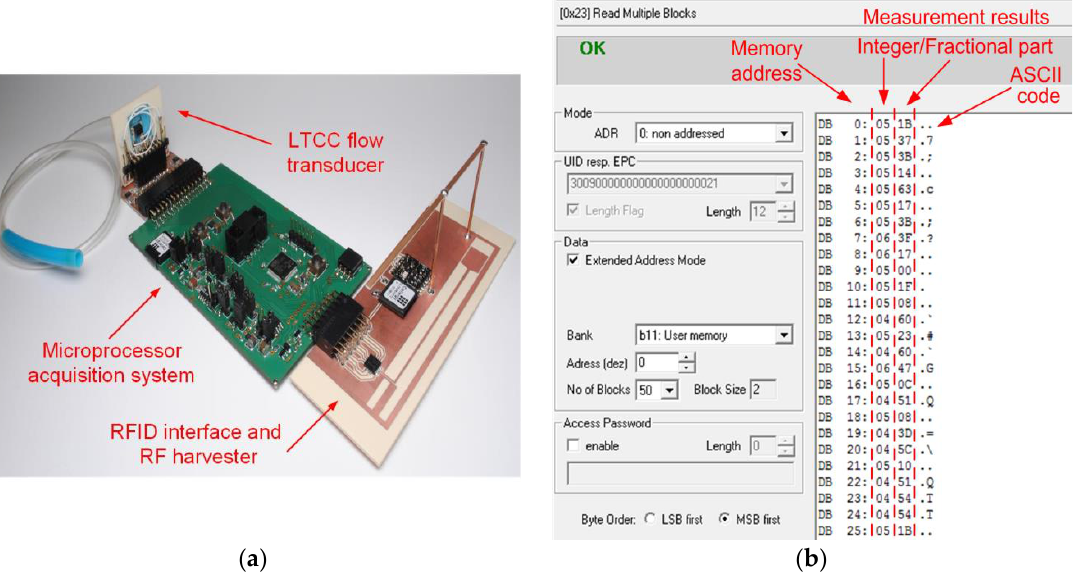
Figure 12. ( a ) Model of the autonomous RFID flow sensor; ( b ) The part of transponder memory with measured data read by RFID interface; ASCII — American Standard Code for